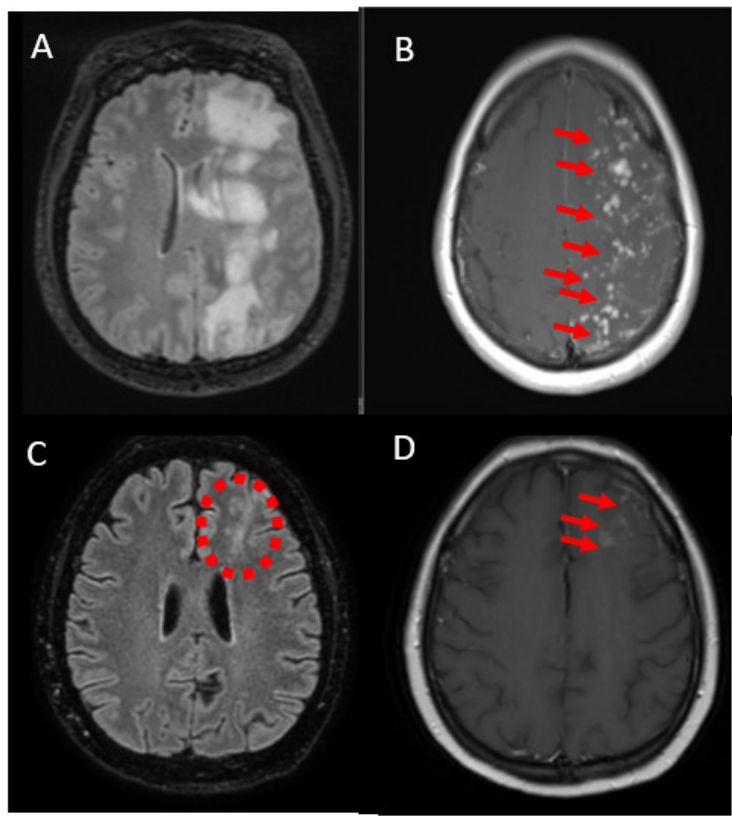
Figure 4. Imaging findings of case 3. FLAIR image with white matter lesions in the left hemisphere ( A ); Axial T1-weighted image showing intense Gd-enhancement (( B ); arrows). Both axial FLAIR- sequence (( C ); dotted circle) and axial T1-weighted image (( D ); arrows) show radiological improvement one month later.